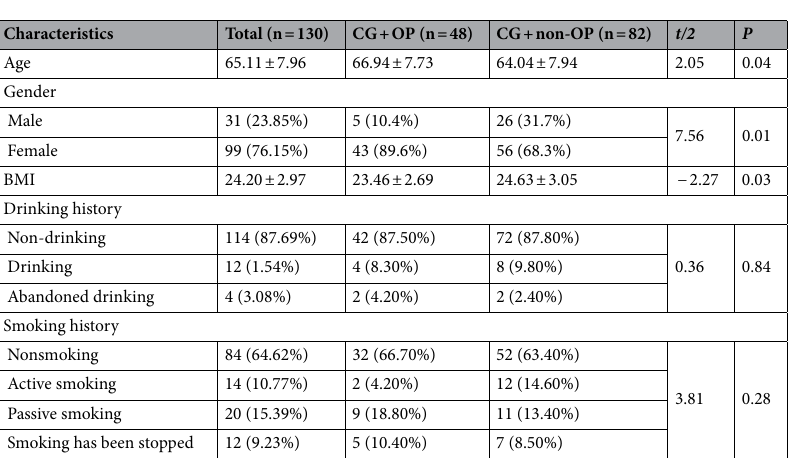
Table 1. Descriptive characteristics of the study population. Data are x ± S, n (%), or n/N (%). p values were calculated by the Mann–Whitney U test, χ 2 test, or Fisher’s exact test, as appropriate.